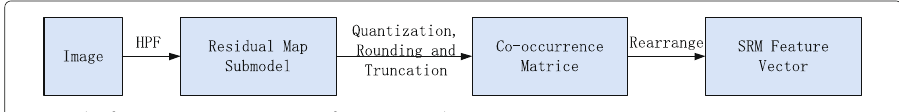
Fig. 1 The feature extraction process of SRM steganalysis